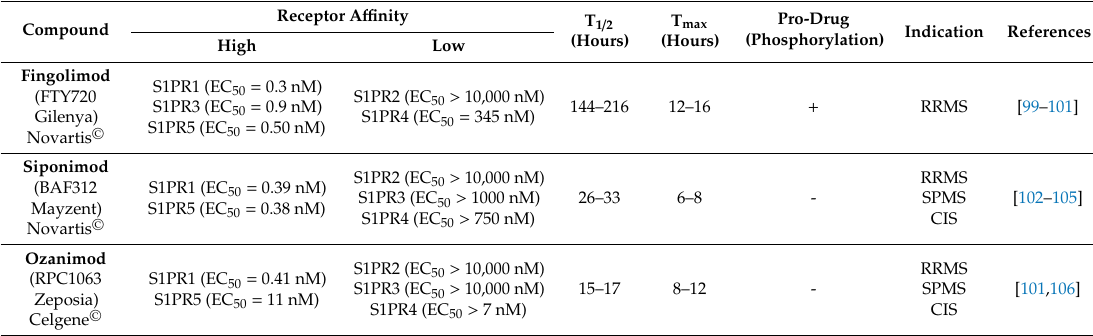
Table 2. Sphingosine-1-phosphate receptor (S1PR) modulators approved for multiple sclerosis (MS) treatment. Features: receptor a ffi nity, half-life (t1 / 2), time to reach the highest plasma concentration (Tmax), required phosphorylation (pro-drug), and indication for MS treatment (relapsing-remitting MS (RRMS); secondary progressive MS (SPMS) and clinically isolated syndrome